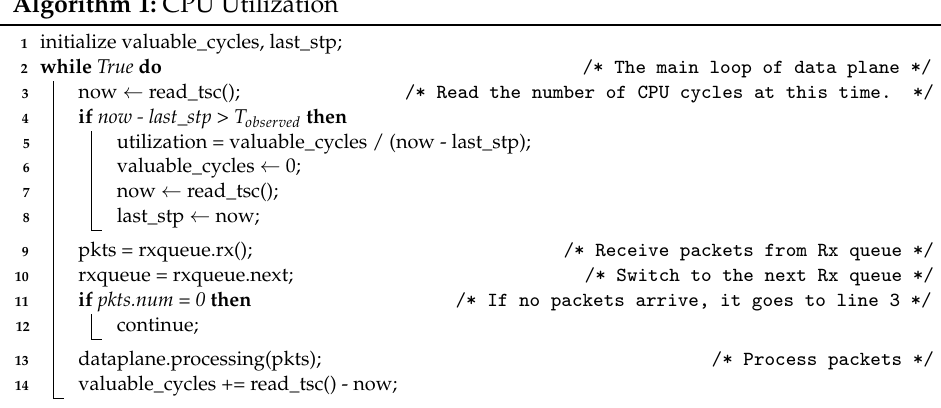
Algorithm 1 is pseudocode that embeds a CPU performance measurement